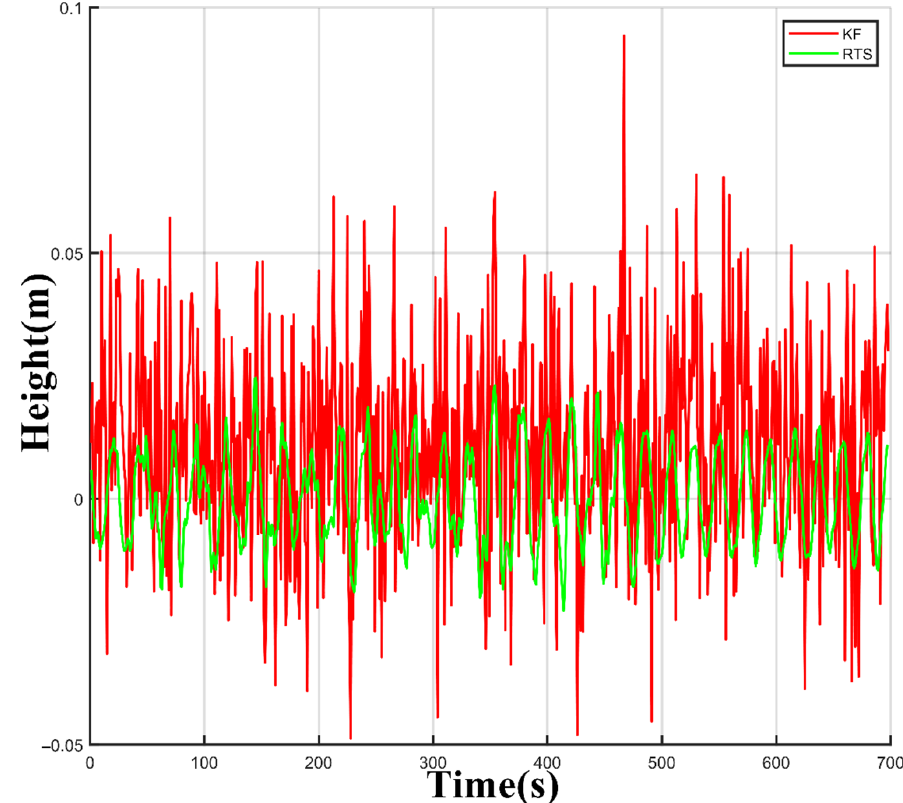
Figure 16. Comparison of elevation error between the KF and